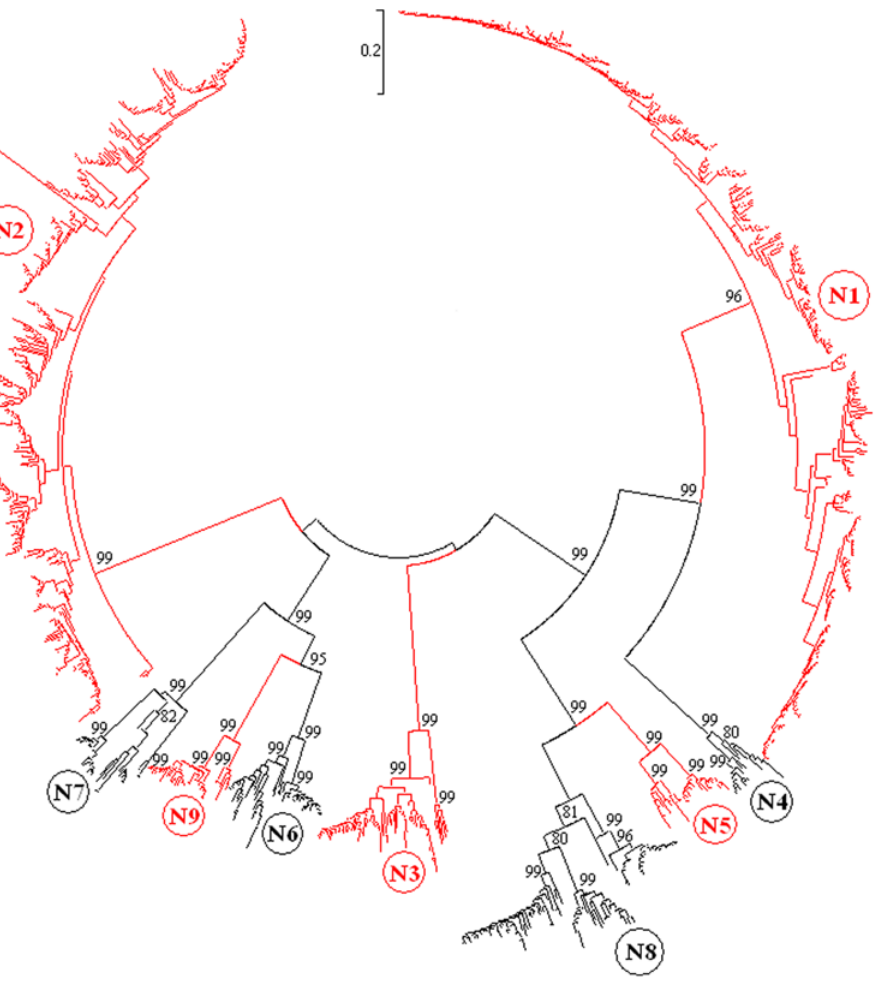
Figure 2. The panorama phylogenetic tree of type A influenza virus based on the viral NA representative sequences. The tree demonstrated that all the 9 NA subtypes were genetically distant to each other, and subtypes N1 and N2 were more dominant than others. The panorama diversity of each of the NA subtypes was detailed in Figure 10 , Figure 14. Bootstrap values were given at relevant nodes.